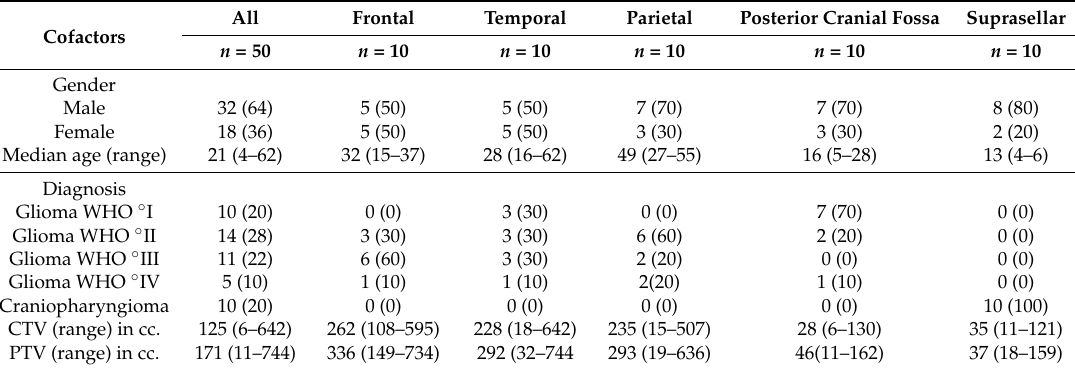
Table 1. Patient characteristics. Numbers in brackets represent percentages and refer to the absolute values in